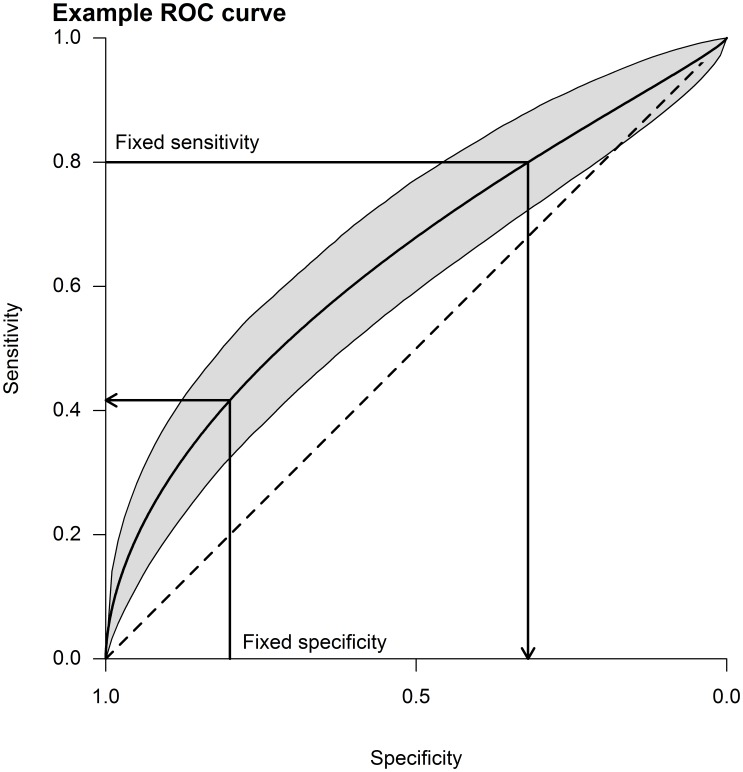
Example Receiver Operating Characteristic (ROC) curve.Note: the threshold at fixed specificity/sensitivity achieved by doctors are used to calculate the corresponding sensitivity/specificity of the prediction model. The shaded area shows the 95% confidence interval about the ROC curve.